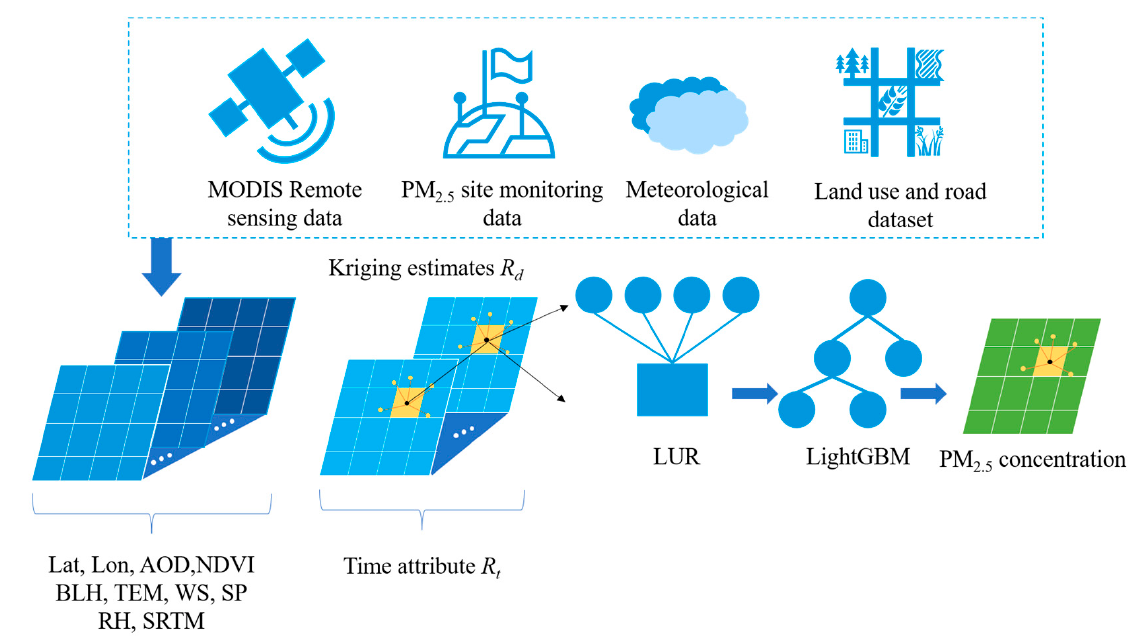
Figure 2. LUR ‐ GBM model structure diagram. Figure 2. LUR-GBM model structure